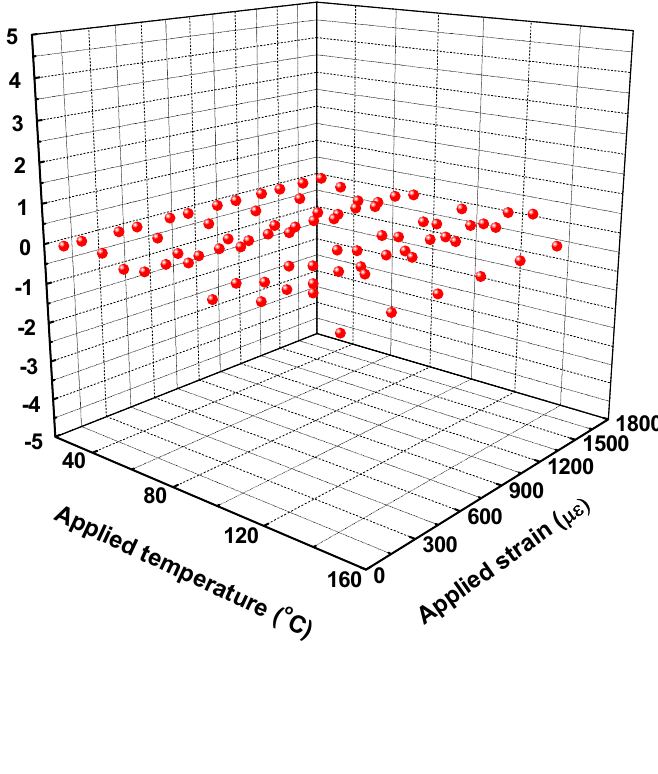
Figure 4. 3D Scatter plot of strain errors with applied temperature and applied